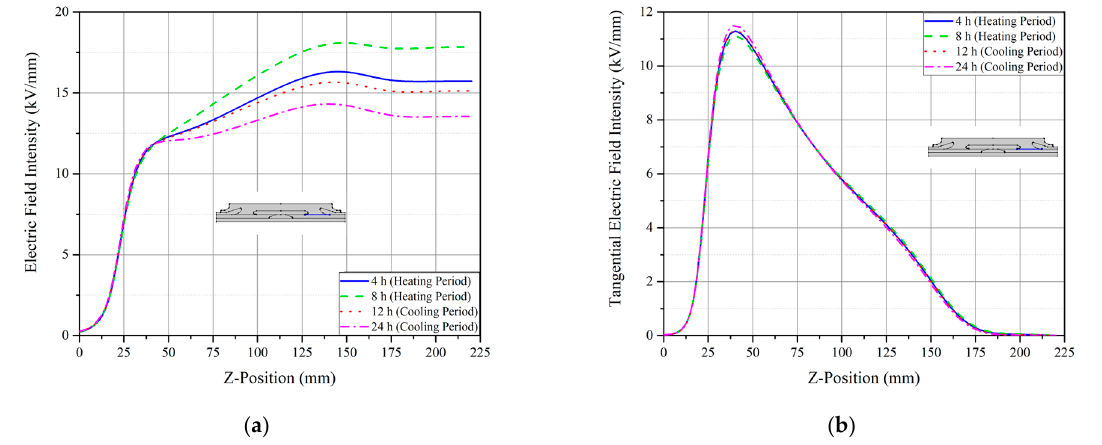
Figure 9. Time-varying electric field distribution at XLPE/SiR interface: ( a ) Electric field intensity at the interface; ( b ) Tangential electric field intensity at the interface. Table 3. The electric field strength and changes during the cooling cycle.